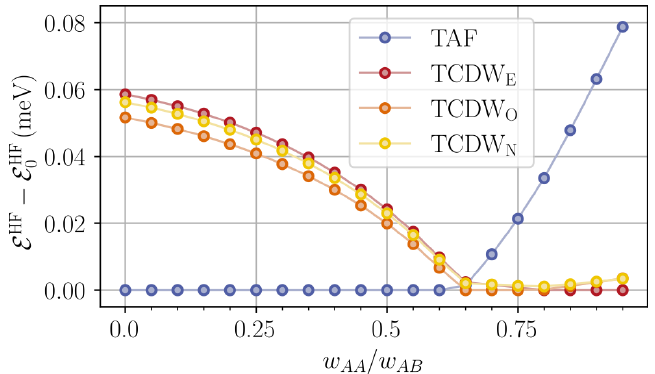
Figure 7: Energies per site of the TAF and TCDW phases relative to the HF ground { w state as a function of w . The different forms of TCDW order stay close in AA AB { w Á 0.7, while there is a significant gap to the TAF phase. energy, especially for w AA AB The crossover of the TAF and TCDW energy lines is reminiscent of the way the spin polarized levels and the singlet evolve through the phase transition in Fig. 3 (c). The applied discretization is